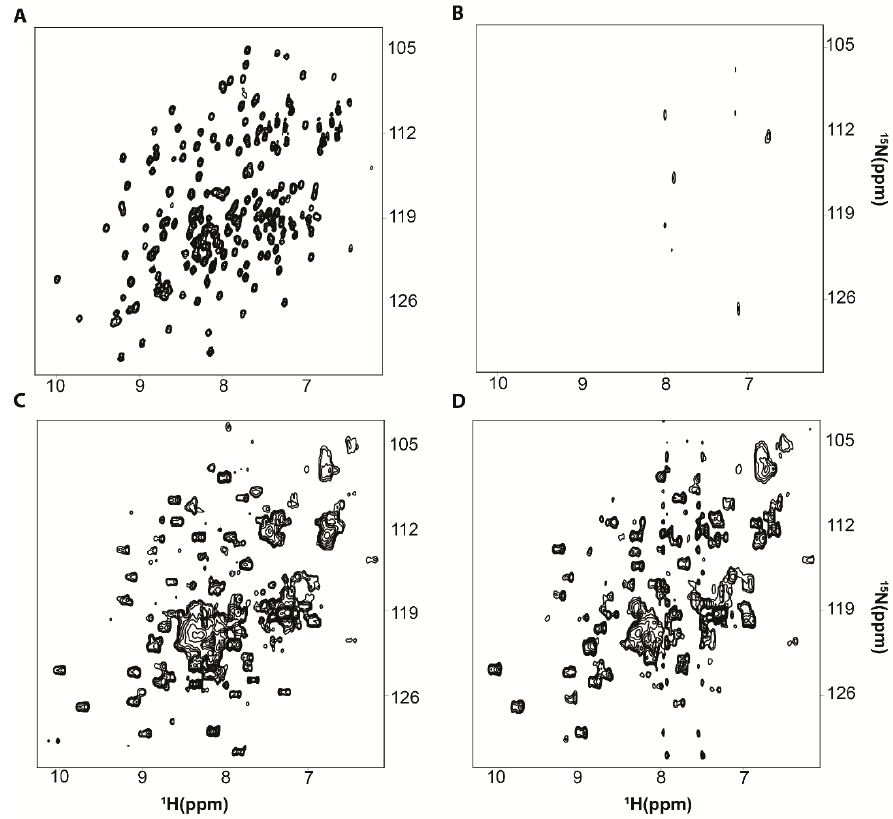
Figure 2. 1 H- 15 N CRINEPT-HMQC-TROSY improves in-cell NMR spectral resolution. ( A ) Lysate HSQC spectrum of [ U - 15 N] Adenylate kinase, ADK. ( B ) In-cell 1 H- 15 N HSQC spectrum of [ U - 15 N] ADK overexpressed for 16–18 h. ( C ) In-cell 1 H- 15 N CRINEPT-HMQC-TROSY spectrum of [ U - 2 H, 15